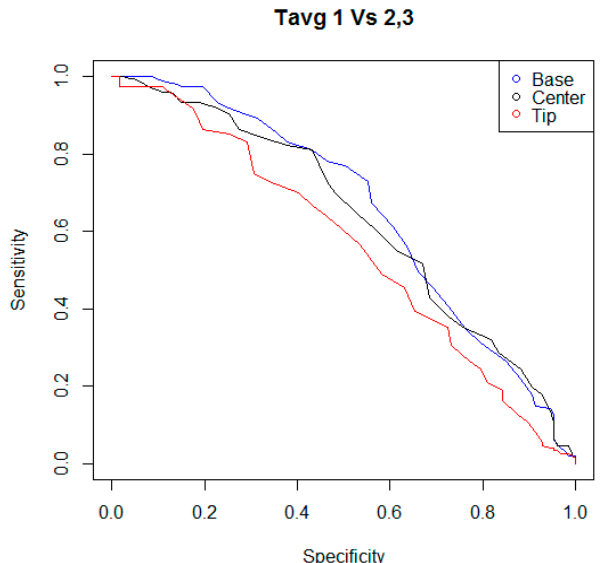
Figure 4. ROC curves of the statistical tests that were built considering the performances of the indicators T avg,B , T avg,C , and T avg,T , and different possible cutoff levels. Teat status was considered as “mechanically stressed” when its scoring fell in the level “two” or “three” of the color change scale adopted.